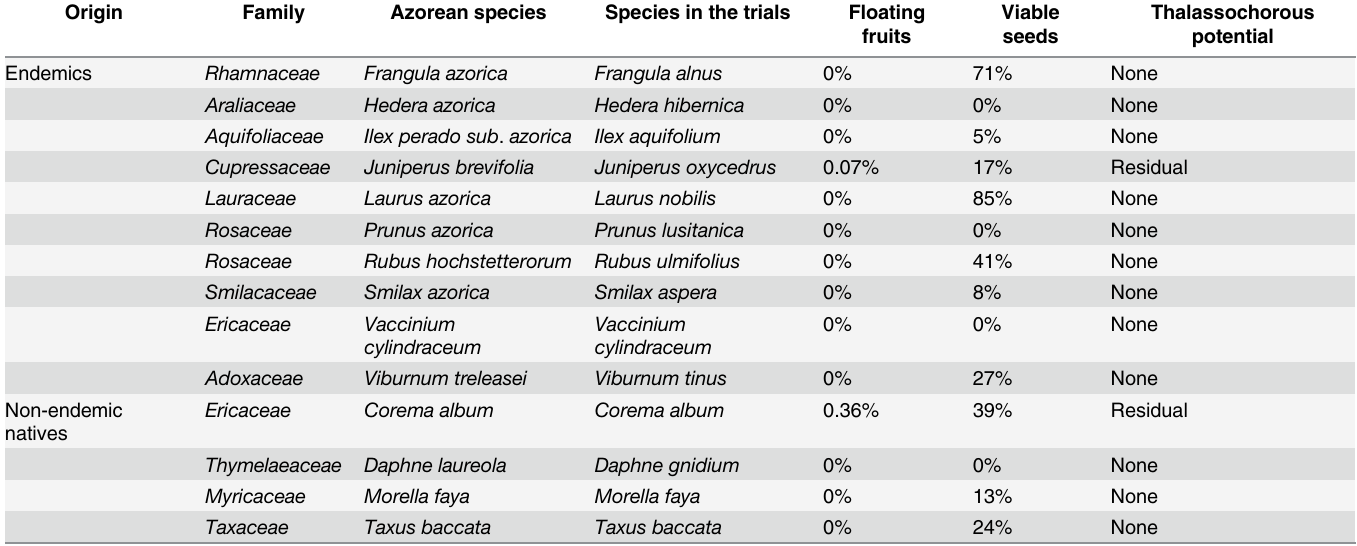
Table 1. Proportion of floating and viable (Tetrazolium test) seeds for 14 European fleshy-fruited species after 60 days of immersion in saltwater, and the inferred potential for oceanic dispersal. Taxonomy of Azorean species followed [34], European taxonomy followed the Flora Europaea of selected plant families